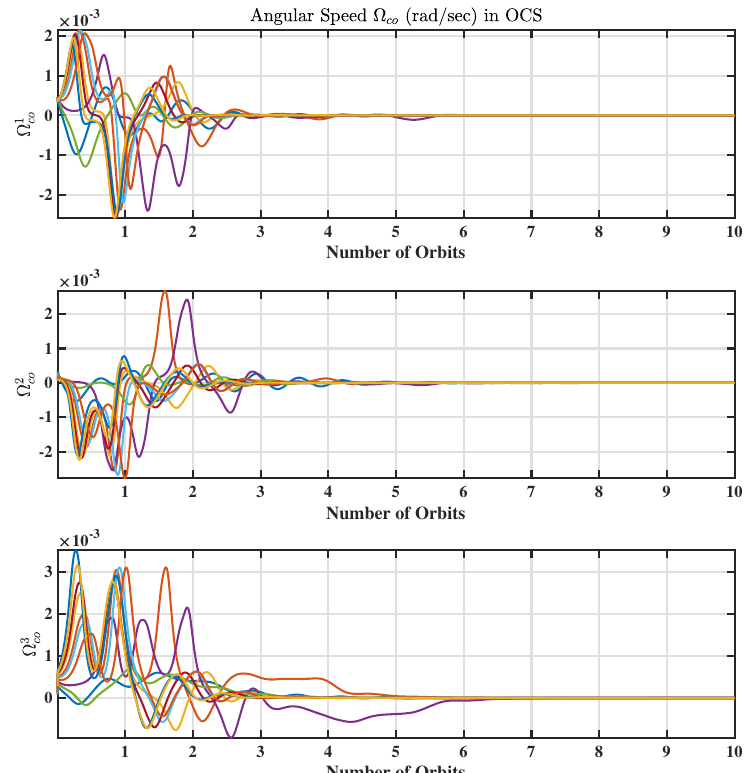
Figure 7. Angular velocities converging to the local equilibrium point after starting from random initial quaternions (in a local neighbourhood). Subplots 1–3 represent angular velocities Ω 1 – Ω 3 ,